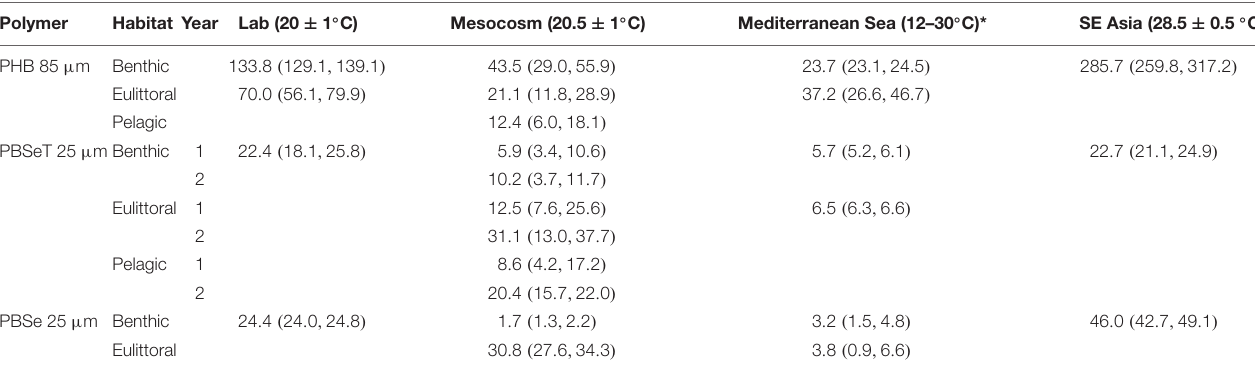
TABLE 4 | Surface micro-bioerosion rates ( µ m · yr − 1 ) of PHB, PBSe, and PBSeT under different marine conditions.